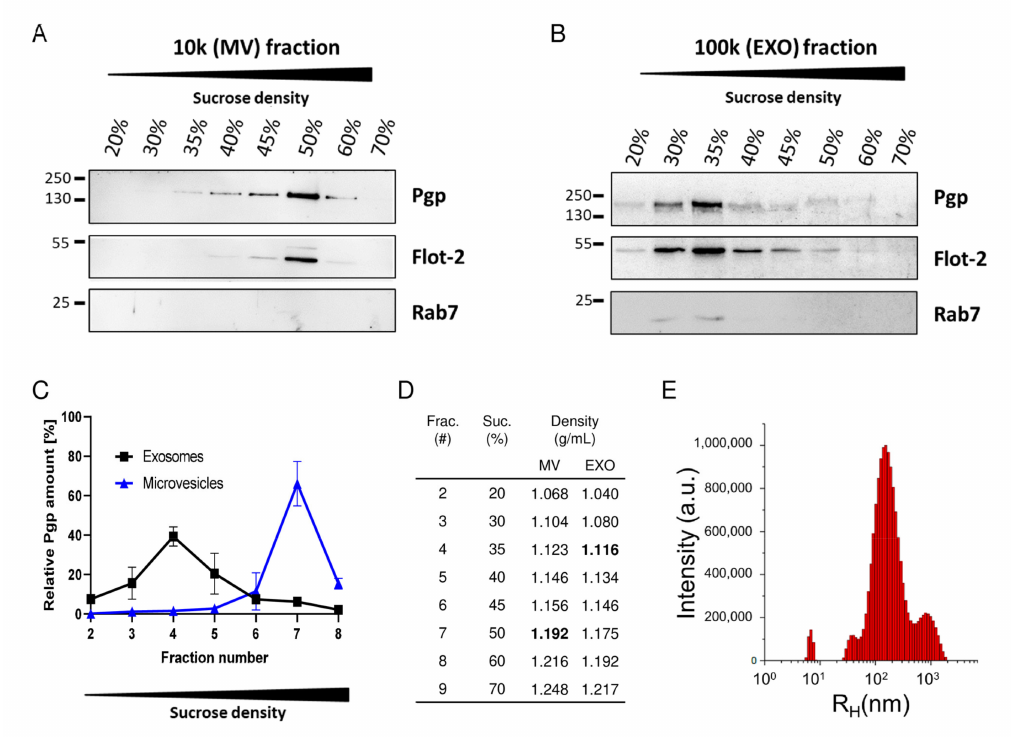
Figure 4. Fractionation of extracellular vesicle subtypes released by doxorubicin-treated hCMEC / D3 (Human Cerebral Microvascular Endothelial Cell Line clonal population D3) cells and analysis of Pgp content. Conditioned medium from doxorubicin-treated hCMEC / D3-cocultures was subjected to di ff erential centrifugation and density gradient centrifugation followed by Western blot analysis of the ( A ) 10,000 × g microvesicle (MV) and the ( B ) 100,000 × g exosome (EXO) isolates after sucrose gradient fractionation (bottom-up flotation). The fractions were probed for Pgp, the lipid raft marker flotillin-2 (Flot-2), and the small GTPase Rab7. ( C ) Relative Pgp protein distribution among sucrose fractions of increasing density collected from gradients loaded with EXO (black line) or MV (blue line) isolates ( n = 2). In accordance with the smaller size of EXOs in comparison to the Pgp-containing MV exosome, isolates mainly distribute to a fraction with low sucrose concentration, whereas Pgp-containing MVs float at a higher sucrose concentration. ( D ) Table presenting sucrose (suc.) concentration (in %) and corresponding densities of the di ff erent fractions (frac.) after gradient centrifugation. ( E ) Size distribution of the EXO isolate was determined by dynamic light scattering. The size of particles is given as hydrodynamic radius (R H ) in nm, and relative abundance is given as arbitrary units (a.u.). The size distribution histogram of the EXO preparation shows a prominent species at ≈ 200 nm (R H ). Data are from unpublished experiments of Birthe Gericke and Felix